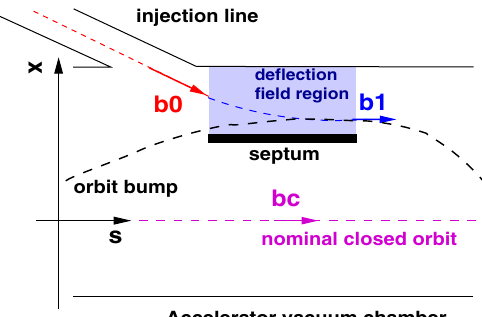
FIG. 1. Schematic picture of the standard on-axis injection by means of a septum and an orbit bump. At the injection into the ring, the beam initial conditions ( b0 in the picture) are modified by the magnetic (or electrostatic) field screened to the rest of the accelerator by a septum. At its exit the beam conditions ( b1 in the picture) are such to match the ones of the orbit bump created by kicker and bumper magnets. After the first turn the orbit bump is reduced until the closed orbit eventually returns to the nominal circular one ( bc in the